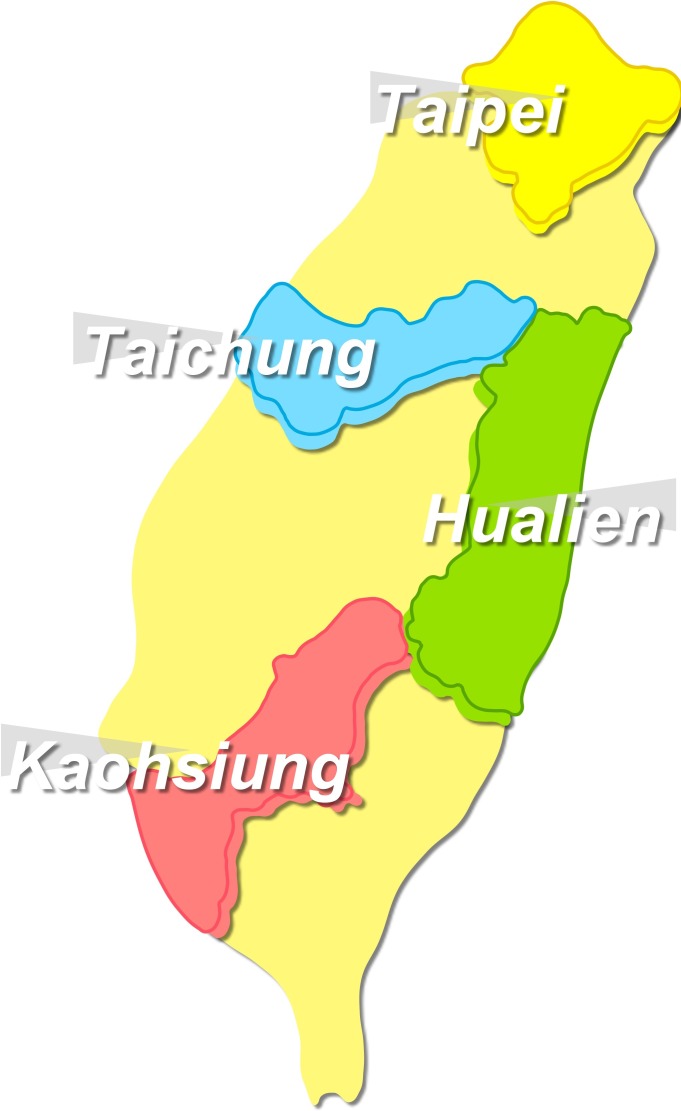
Geographical sites with continuous medical education courses being held in Taiwan.